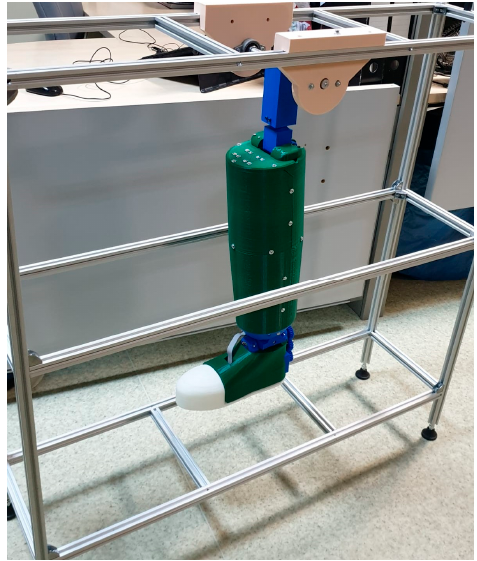
Figure 3. Experimental setup of the prosthesis.